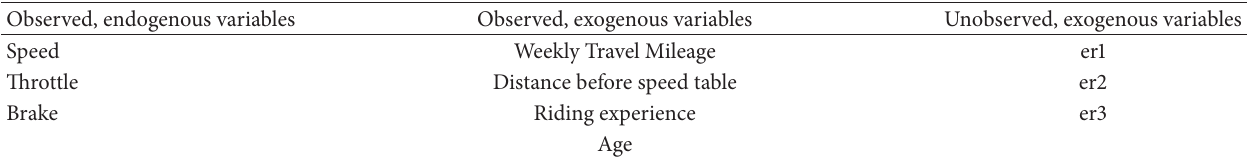
Figure 8: Path model for the prediction of riding behaviour before speed table. Table 4: List of model variables.